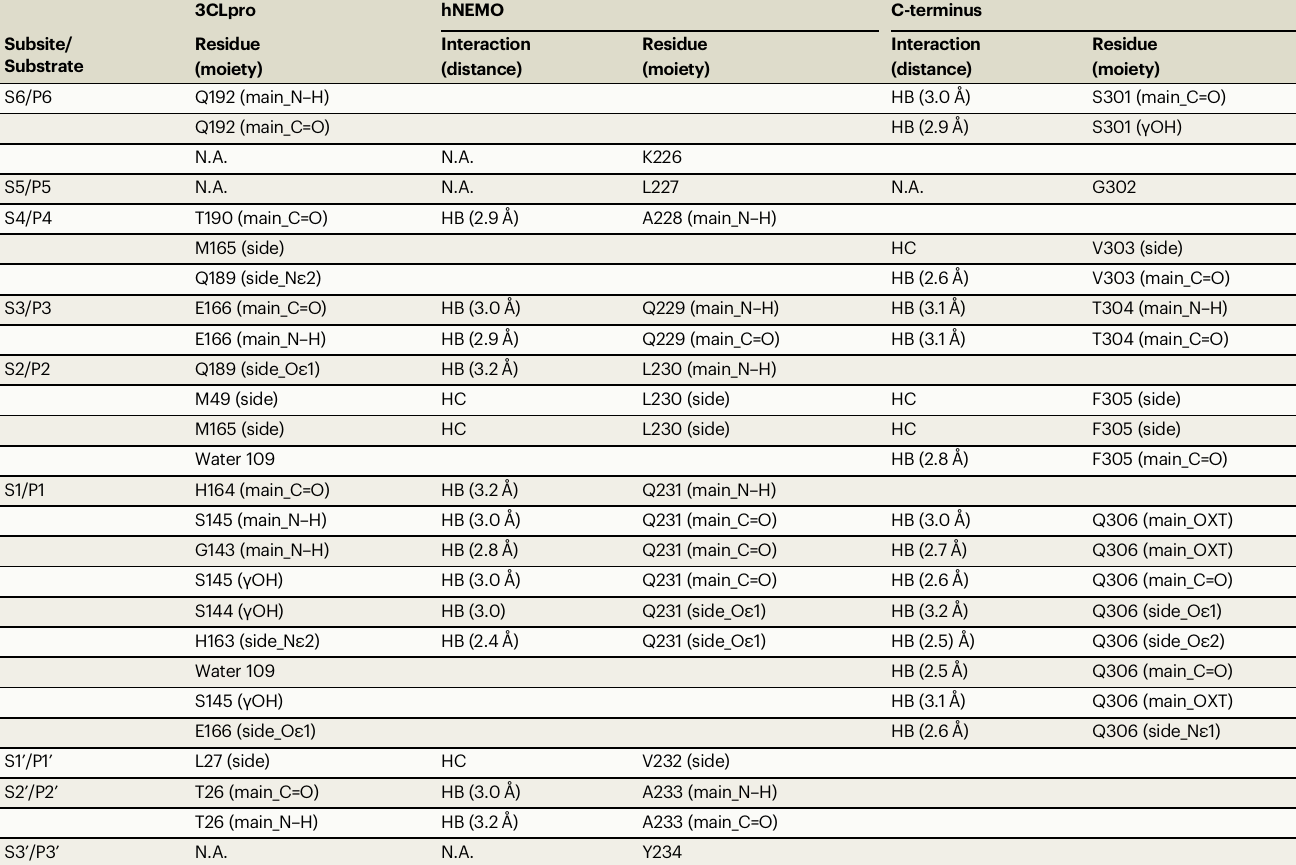
Table 1 | Interactions of SARS-CoV-2 3CLpro C145S with both bound hNEMO 226 – 234 and bound C-terminal tail in the crystal structure 3CLpro